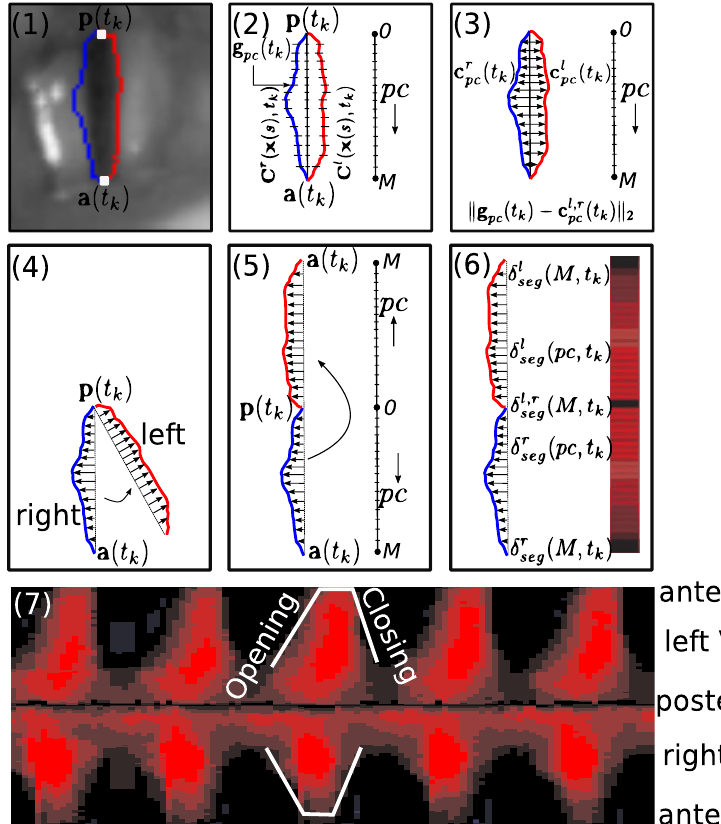
Figure 13. Schematic representation of the PVG playback. (1) Segmentation; (2) Resampling of the extracted vocal folds edges; (3) Computation of vocal folds deflections δ l , r seg ( pc , t k ) ; (4) Splitting of the glottal axis; (5) Virtual turning of the left fold; (6) Color coding of the vocal fold deflections; (7) I PVG ( x , y ) representing a HSV with five glottal cycles. Adapted from